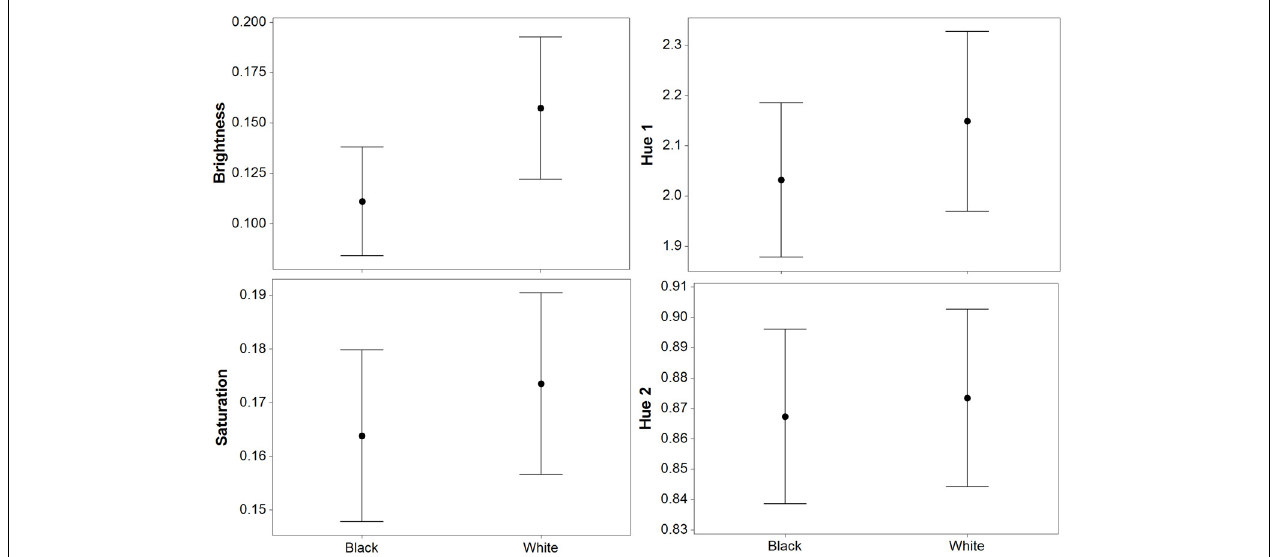
FIGURE 7 | Results (means plus standard error) from experiment 1 (black and white backgrounds) when analyzed with reflectance data. Differences in luminance (perceived lightness) and saturation were significant,